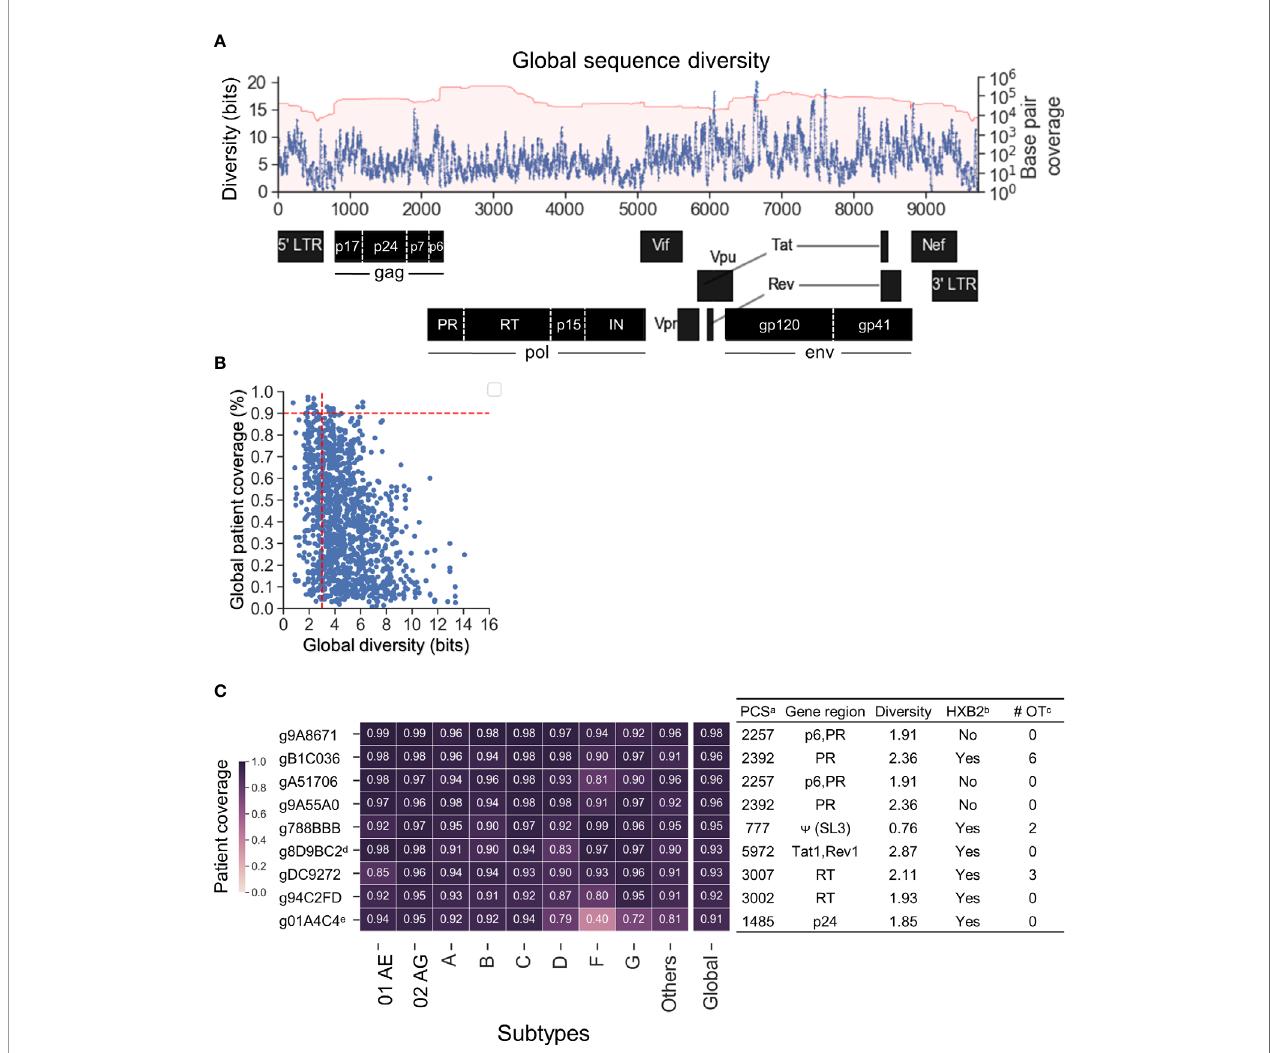
FIGURE 3 | Nine lead gRNAs were identi fi ed with high coverage across subtypes. (A) The map of global sequence diversity estimated by subtype diversity weighted by estimated global prevalence. (B) Scatterplot between global diversity and global patient coverage. Vertical dashed line showed a cutoff of 3 for global diversity and 0.9 for global patient coverage. Nine lead gRNAs were advanced by the cutoff selection. (C) The heatmap of subtype-speci fi c patient coverage and global patient coverage. Of the nine gRNAs shown, two were previously published. The additional seven are novel gRNA sequences targeting fi ve distinct HIV-1 genes/motifs as aligned against HXB2. a PCS: Predicted cleavage sites; b HXB2: Whether the absolute gRNA sequence perfectly matched with HXB2 reference sequence. Note that the NL4-3 and R7/E-/eGFP in J-Lat (Chung C.-H. et al., 2020b) also showed the same results as HXB2 ( Table S1 ); c# OT: number of potential off-target sites with CFD above 0.569 in human genome. d g8D9BC2: Previously published as gTatRev in (Wang et al., 2016a; Wang et al., 2016b; Darcis et al., 2019); e g01A4C4: Previously published as gGag3 in (Wang et al., 2016a; Zhao et al.,